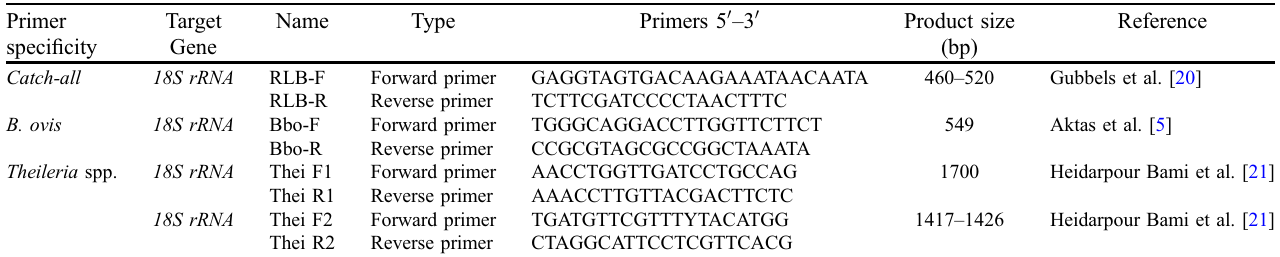
Table 1. Primers used for detection by PCR of Babesia ovis and Theileria spp. from sheep and goats in this study. Primer